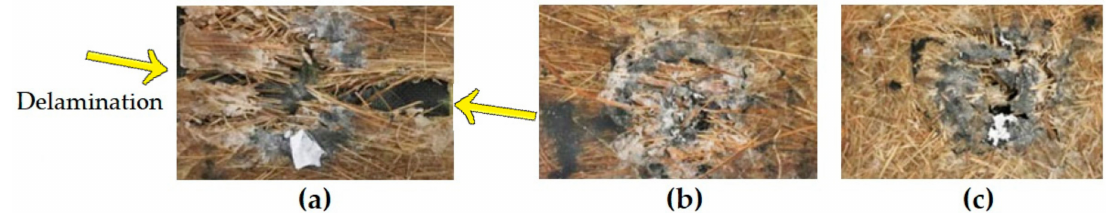
Figure 8. General macroscopic aspect after ballistic test of MAS targets with second layer of epoxy composites reinforced with 30 vol% of guaruman fibers: ( a ) continuous aligned, ( b ) cross-laid, and ( c ) short-cut randomly dispersed; all backed by 5 mm thick Kevlar TM